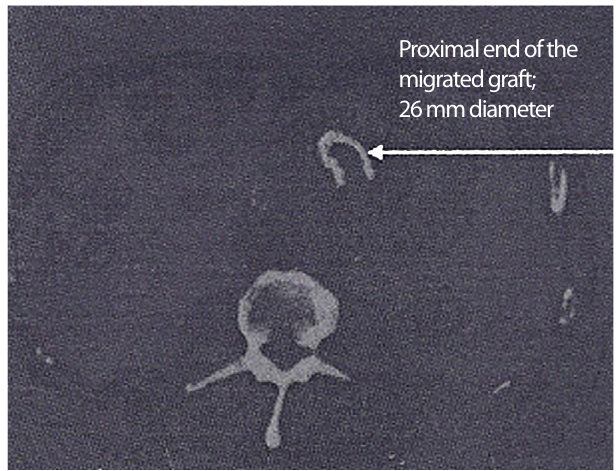
Fig. 1 – Pre-operative computed tomography (CT) scans: proximal end of migrated graft within the aneurysm sac.